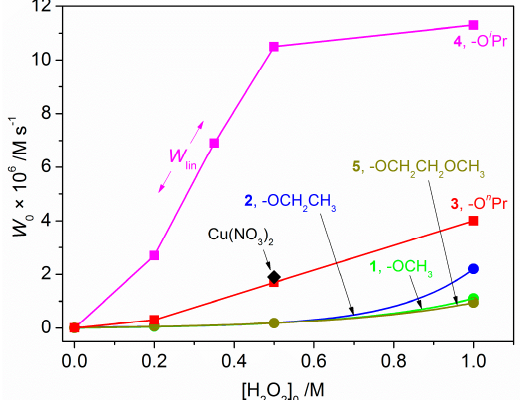
Figure 5. Dependences of the oxidation rates W 0 on initial concentration of hydrogen peroxide in the oxidation of cyclohexane (0.2 M) with H 2 O 2 (50% aqueous) in the presence of pyridine (0.01 M) in acetonitrile at 50 °C. For complex 4 (purple line), the reaction rate was calculated at the quasi-linear period ( W lin ) because no lag period was observed for [H 2 O 2 ] 0 > 0.2 M.